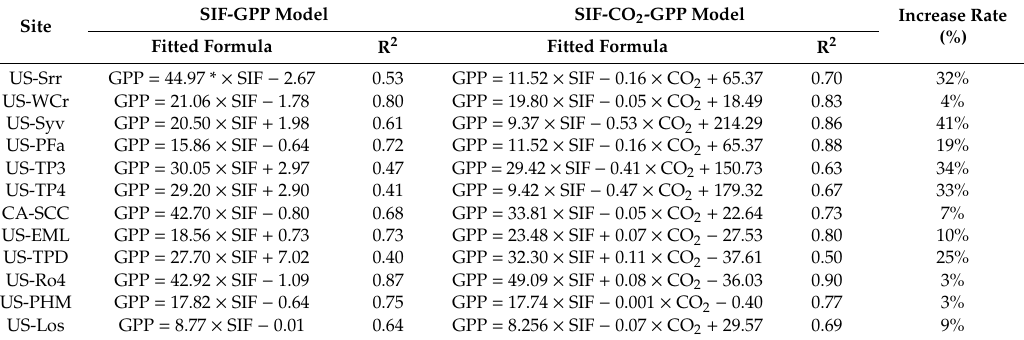
Table 3. Comparison of the SIF-GPP model and the SIF-CO 2 -GPP model. Increase rate is the di ff erence between the R 2 of both models. The CO 2 data comes from the EC flux tower.